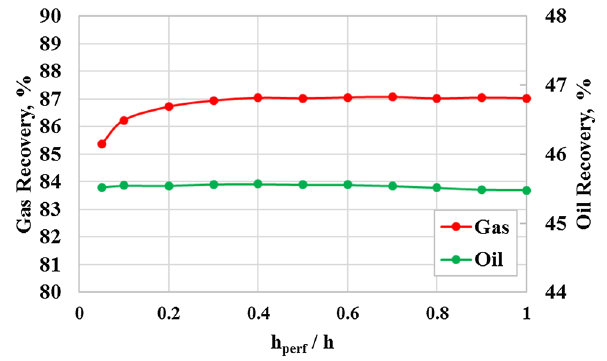
Fig. 26 Field production life and water breakthrough time for differ- ent completion lengths